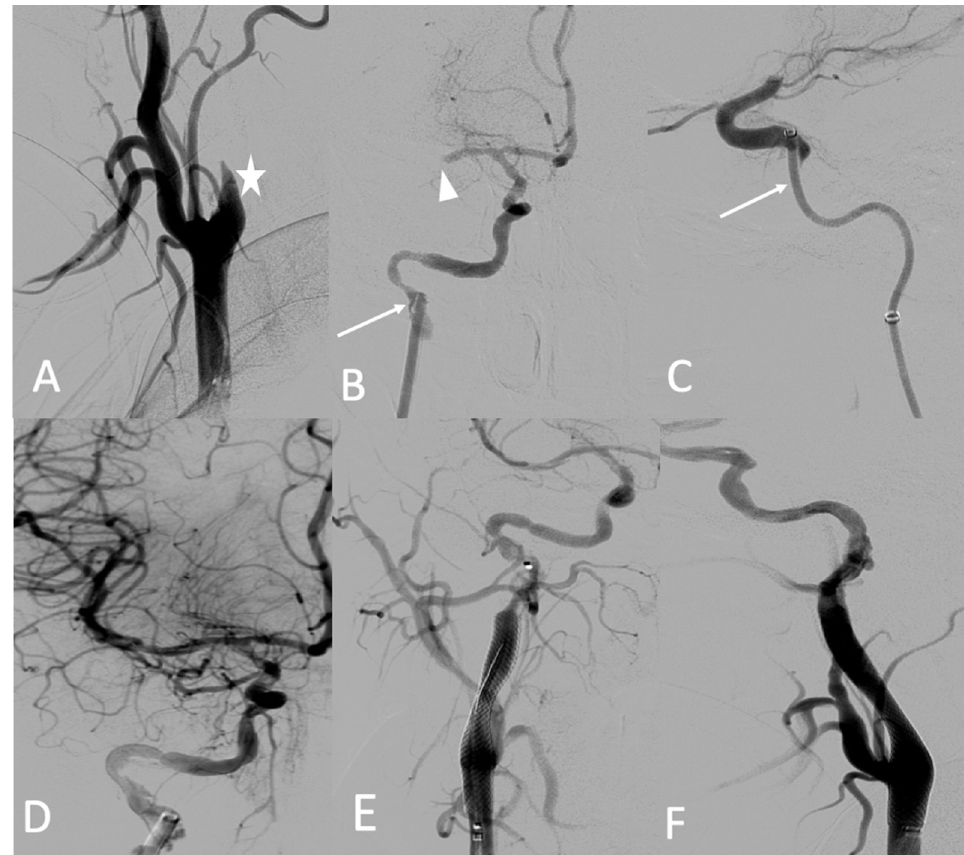
Figure 6. ( A ) Digitally subtracted image from the right common carotid angiogram showing occlusion over the dissection of the right internal carotid artery (star); ( B , C ) crossing the dissection by a Sofia 6 F aspiration catheter (arrows) and the occlusion of the proximal portion (M1) (arrowhead); ( D ) anterior view after mechanical thrombectomy; ( E , F ) anterior and lateral views after the deployment of the carotid wall stent.